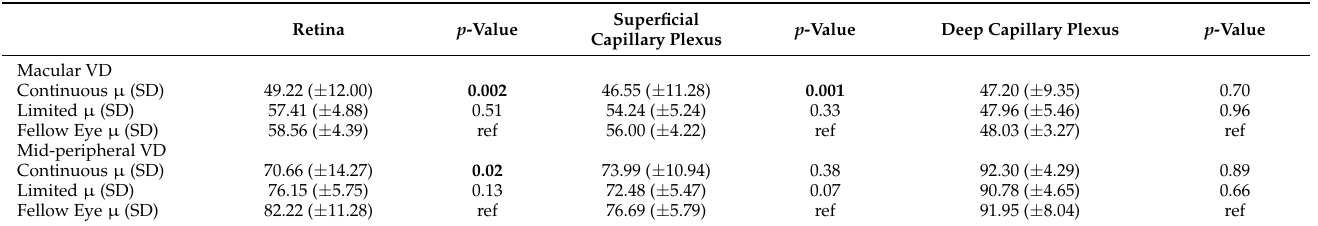
Table 2. Vessel density in the macula and mid-periphery in the retinal, SCP, and DCP in eyes with retinal vein occlusions.